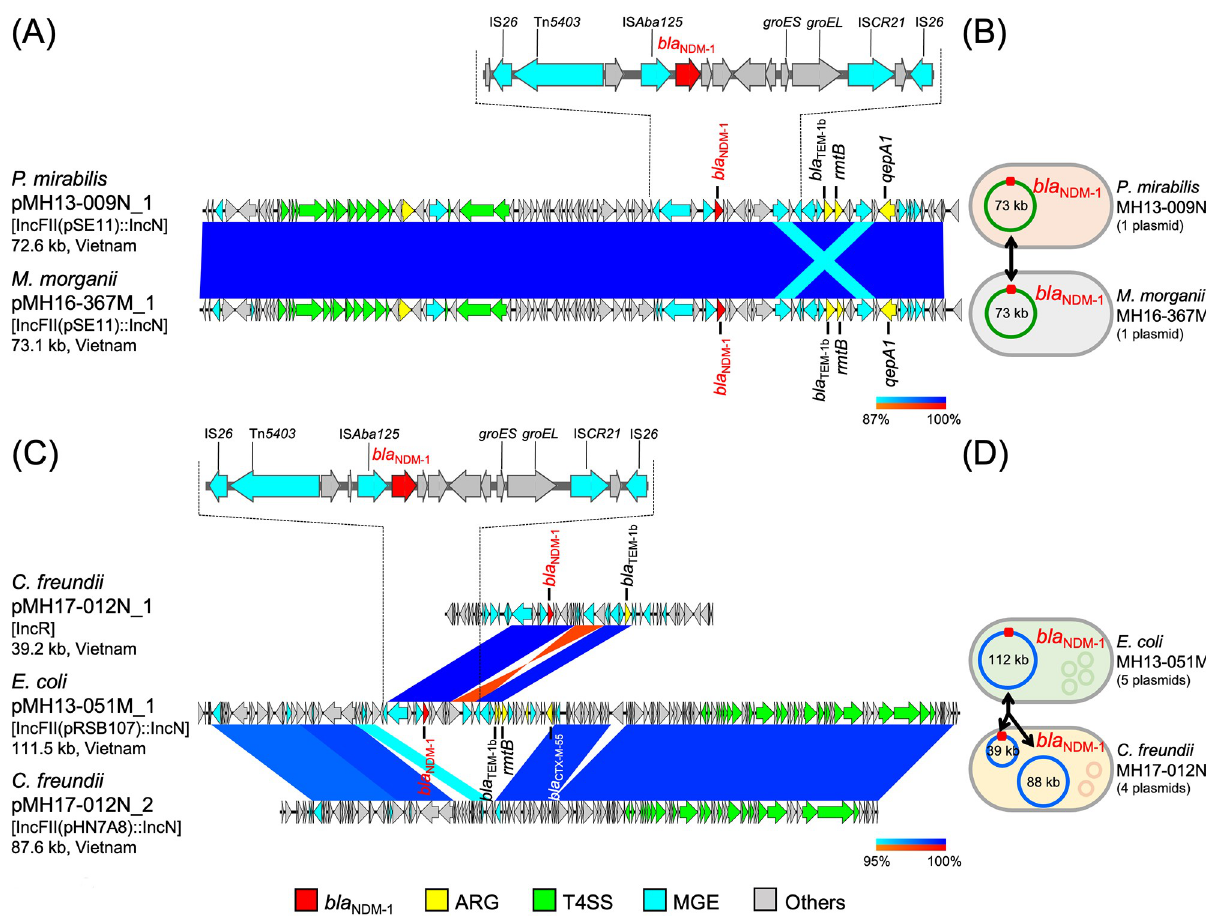
Fig 2. bla NDM-1 -carrying plasmids and the detailed genetic structures around bla NDM-1 in carbapenem-nonsusceptible Enterobacterales isolates sequenced using ONT MinION and Illumina systems. Sets of plasmids from P . mirabilis MH13-009N (pMH13-009N_1, accession: AP018566) and M . morganii MH16-367M (pMH16-367M_1, accession: AP018565), and from E . coli MH13-051M (pMH13-051M_1, accession: AP018572) and C . freundii MH17-012N (pMH17-012N_1, accession: AP018567 and pMH17-012N_2, accession: AP018568), are shown. (A) and (C) Linear comparison of bla NDM-1 -carrying plasmid sequences. (B) and (D) Schematic representation of possible transfer of plasmids, including bla NDM-1 -carrying plasmids. Circles within bacterial cells show plasmids, and red squares on plasmids show bla NDM-1 . Sets of plasmids from P . mirabilis MH13-009N and M . morganii MH16-367M (A and B), and from E . coli MH13-051M and C . freundii MH17-012N (C and D), are shown. Red, yellow, green, blue, and gray arrows indicate bla NDM , other important AMR genes (ARGs), type IV secretion system (T4SS)-associated genes involved in conjugation, mobile gene elements (MGEs), and other genes, respectively. The colors in comparison of plasmids show percent identity and sequence direction as indicated. Blue for matches in the same direction and red for matches in the inverted